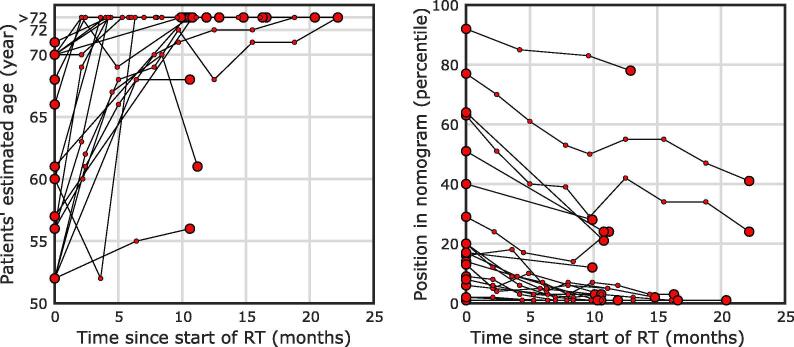
Change in patients’ hippocampal age (left) and position within the nomogram (right) based on the UK Biobank [26], estimated using all available clinical MRIs. Hippocampal age saturates at the top of the graph because age within the nomogram has a maximum of 72. Large points denote first and last available MRIs, small points those in between.